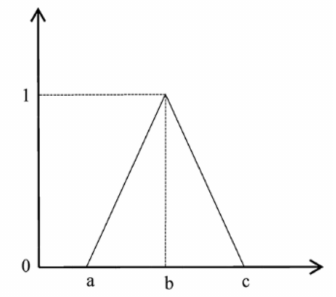
Figure 2. A triangular fuzzy